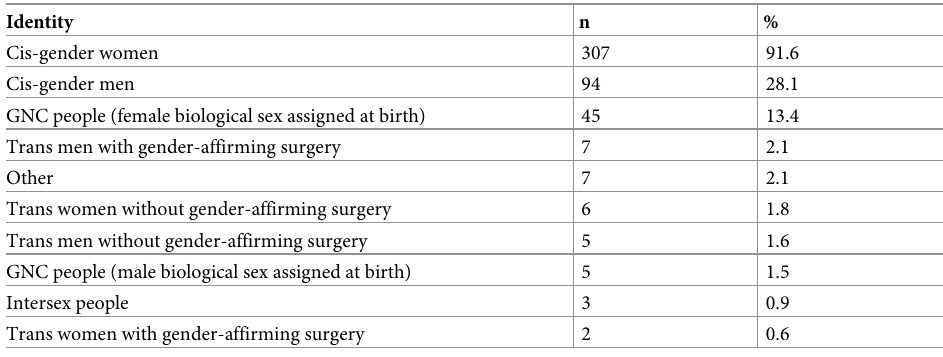
Table 4. Gender identities of lifetime sex partners.